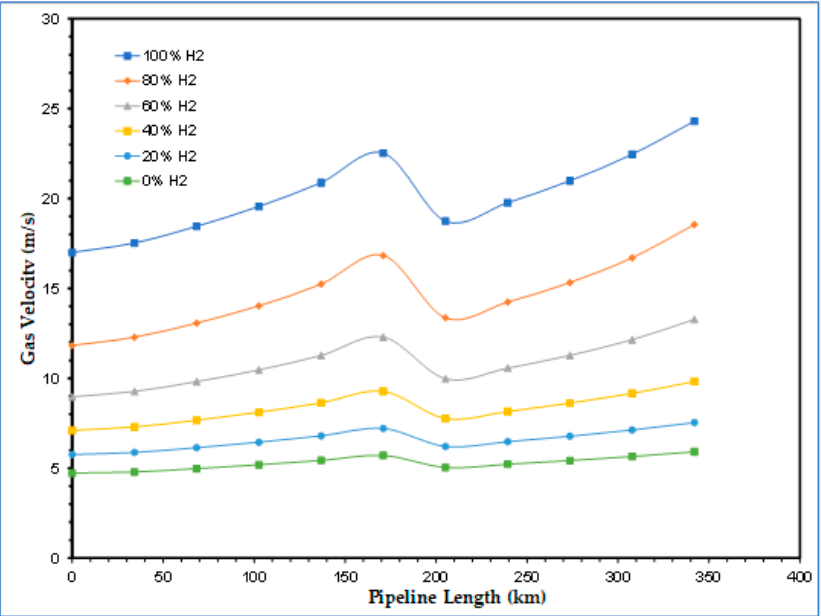
Figure 12. Velocity profiles of hydrogen and hydrogen blends in gas pipelines with a single compressor station (60 bar, 303.15 K).